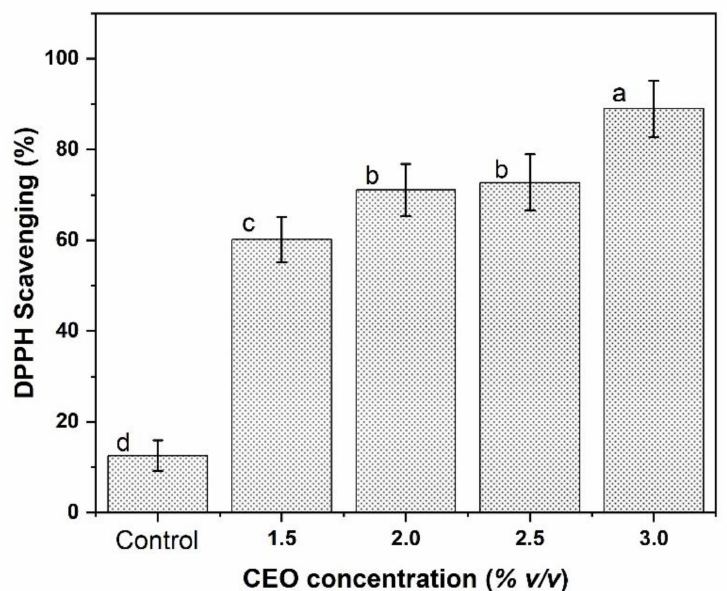
Figure 8. The effect of addition eugenol group contained in CEO incorporated into SA/KC film matrix against DPPH activity. a,b,c,d The reported data are the average and standard deviations where values in each bar with different letters are significantly different ( p < 0.05).